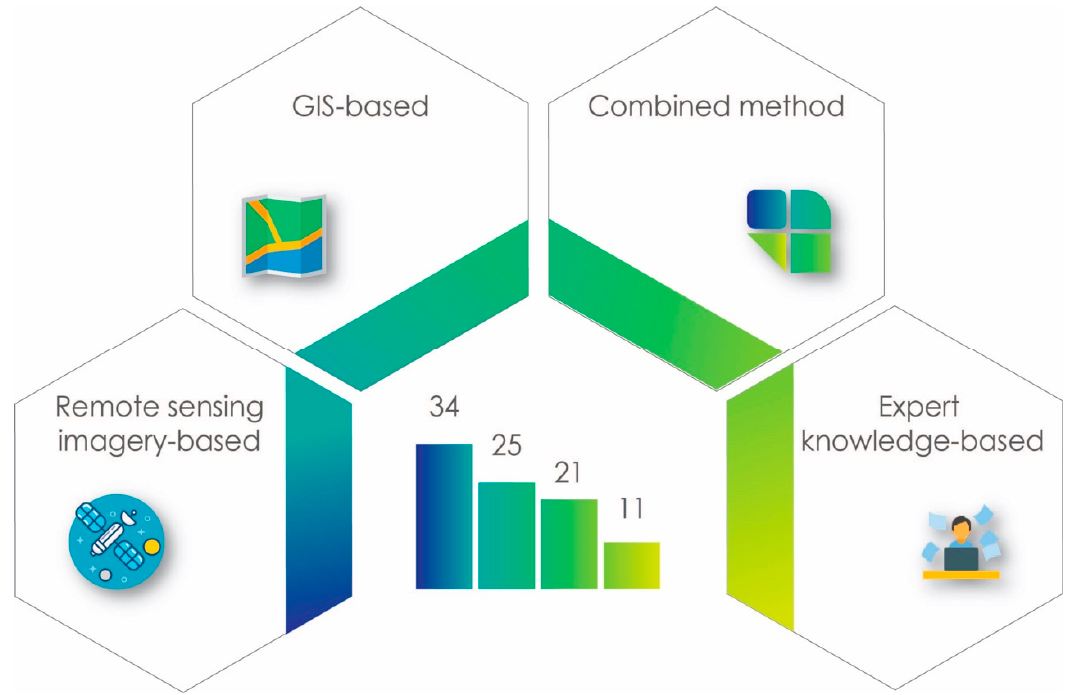
Figure 6. Distribution of studies by methods employed for the detection and delineation of LCZs.